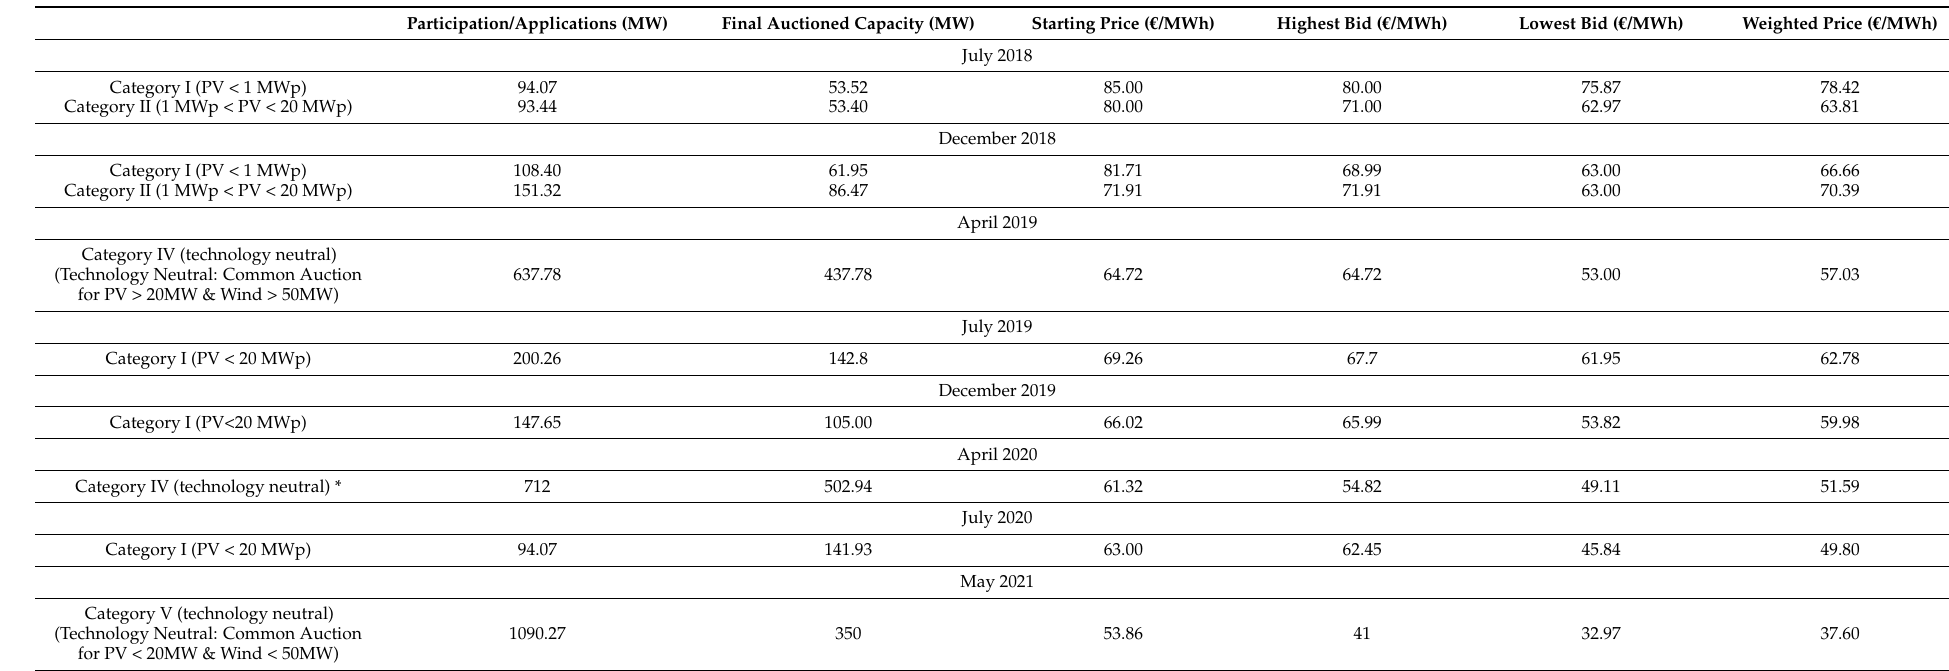
Table A1. RES Auctions Results (PV & Technology Neutral), Source: Regulatory Authority for Energy